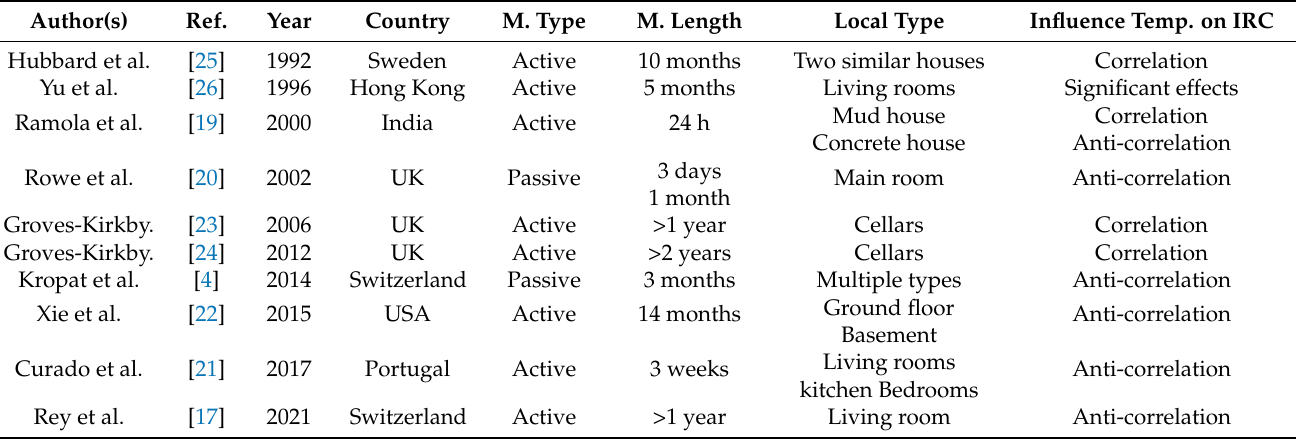
Table 1. Synthesis of outdoor air temperature influences on IRC highlighted in some literature. (Ref.: references; M.: measurements; Temp: